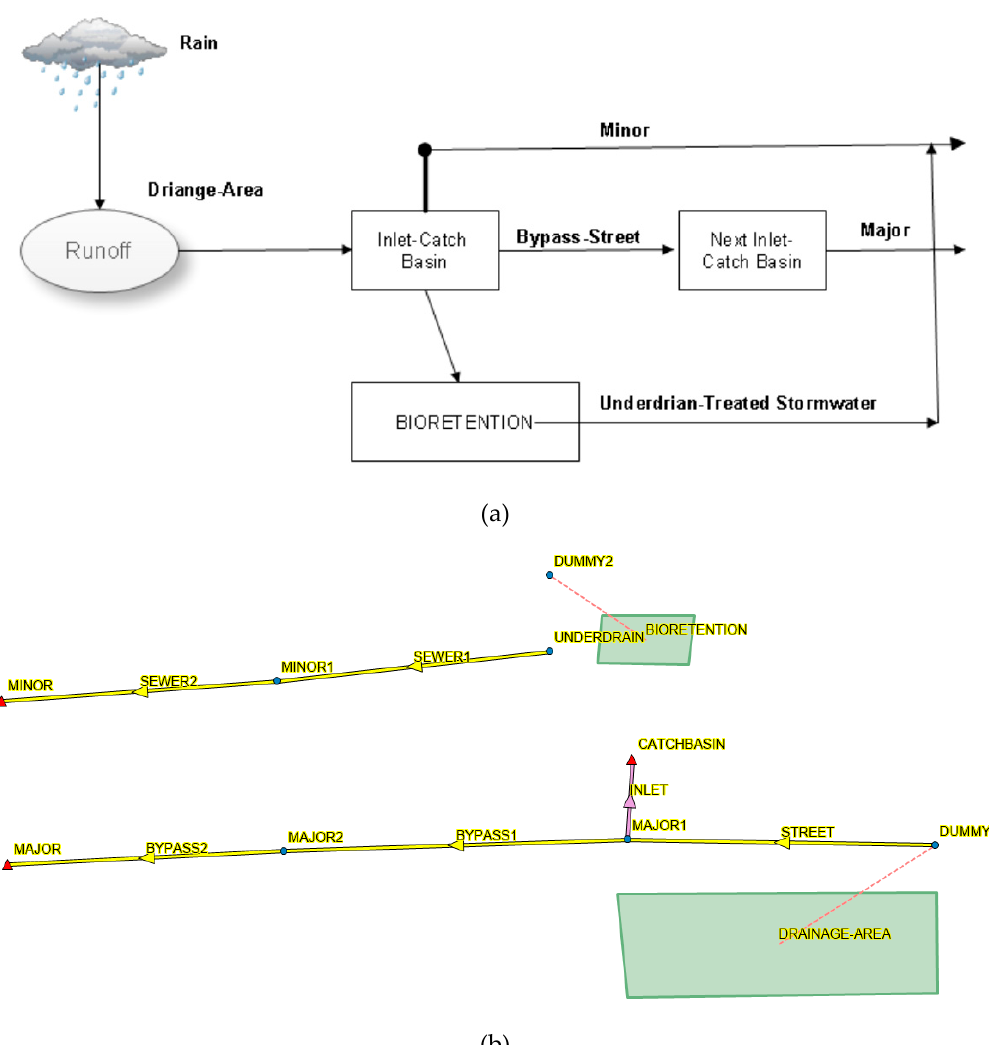
Figure 3. Toronto inlet capacity curves for different catch basins .